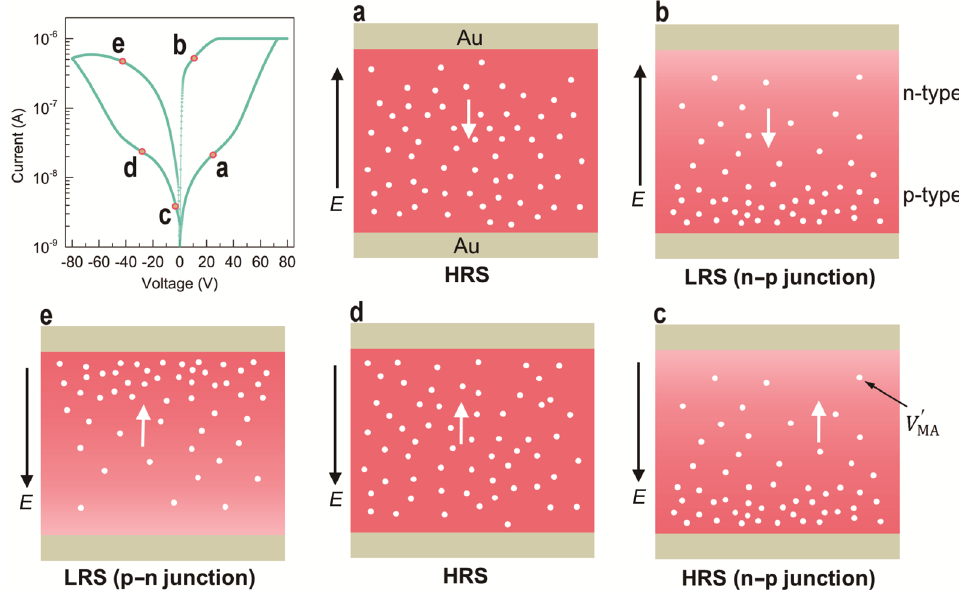
Fig. 3 Schematic diagram describing the rectifying and RS behavior of electronic states in MAPbBr 3 single crystal. Negatively charged V  is focused, and the inclusion of other defects actually does not alter the conclusion. The MA vacancies respond to MA external electric field E . (a) The MA vacancies display an evenly distributed insulating state. (b) In a negative field (bottom to up), MA vacancies are moving downward and accumulating near the bottom surface and are frozen when the field is turned off. As a result, a state with p-type carriers is realized; the opposite region becomes a n-type conductor. Then the internal p–n junction is formed and the diode-like I–V shape could be found (point b  c). (d) Applying the opposite electric field moves MA vacancies to the original evenly distribution, thus forming an HRS state. (e) An inverted p–n junction will be formed by further increasing the opposite electric